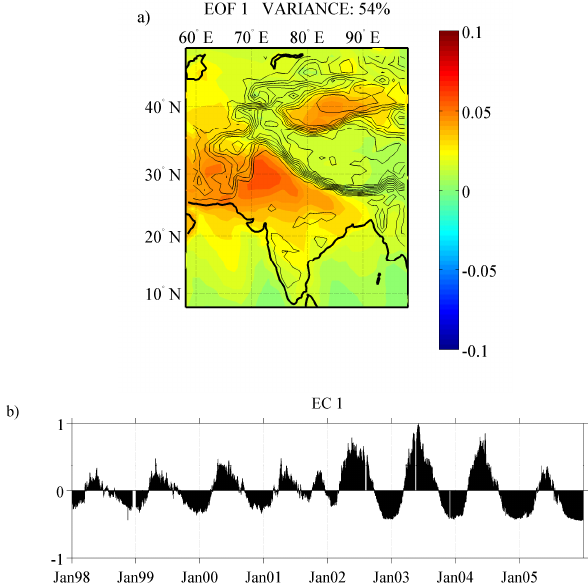
Fig. 4. EOF 1 (a) and EC1 (b) computed from TOMS daily aerosol index (AI) indicate a dominant mode over the Indus river basin Figure 4: EOF 1 (a) and EC1(b) computed from TOMS daily aerosol index (AI) indicate and Thar desert with a sharp west-east gradient along the southern a dominant mode over the Indus river basin and Thar desert with a sharp west-east gradient along slopes of the Himalayas. the southern slopes of the Himalayas.